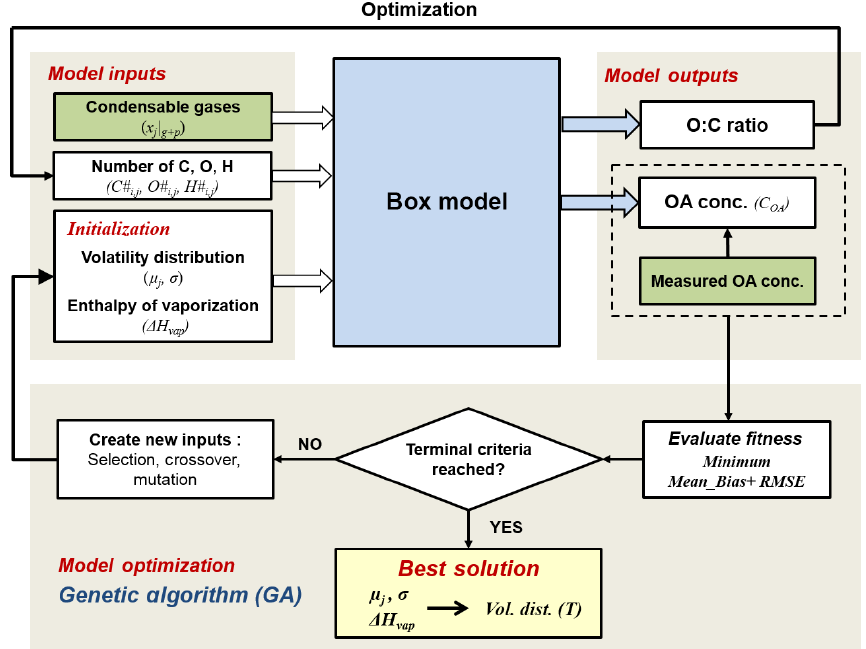
Figure 1. Schematic of the modelling framework. The box model simulates the formation of SOA from each precursor class j in volatility bins i . The best solution of the initialized input parameter volatility distribution (described as the mean value of log C * for each precursor class µ j and standard deviation σ ) and enthalpy of vaporization ( (cid:49)H vap ) parameters are optimized by a genetic algorithm, using minimum mean bias and root-mean-square error (RMSE) between modelled and measured OA concentration as the fitness function. Green boxes represent measured data from the chamber